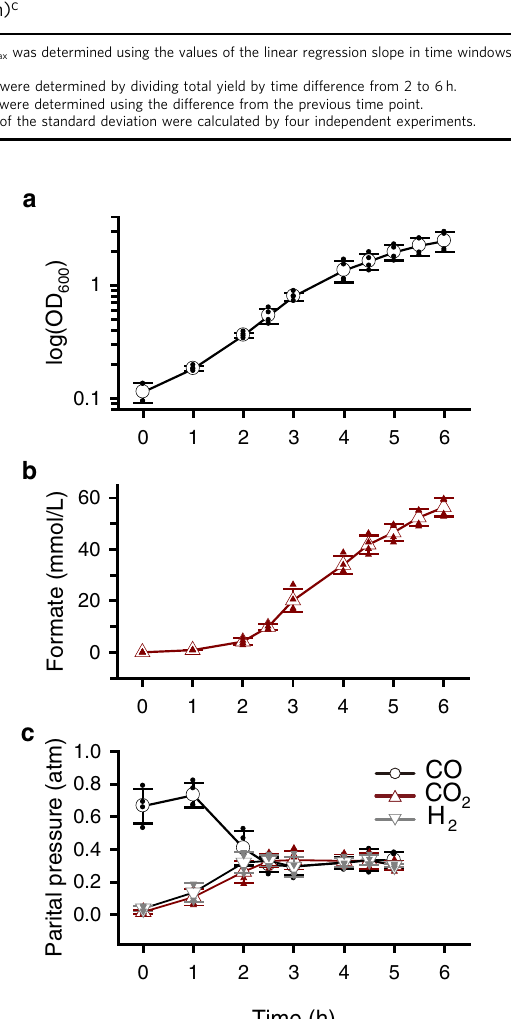
Fig. 4 CO-dependent fed-batch culture in bioreactor. a Cell growth was monitored by measuring OD 600 . b Formate production was determined by HPLC. c Partial pressure of CO, CO 2 and H 2 in headspace was determined by GC. CO (100%) was supplied with initial fl ow rate of 0.02 vvm and was raised to 0.122 vvm during the fed-batch culture. The data were presented as the average ± SD (open symbol), and all the individual data points were shown (closed symbol). Error bars represent ± SD ( n =